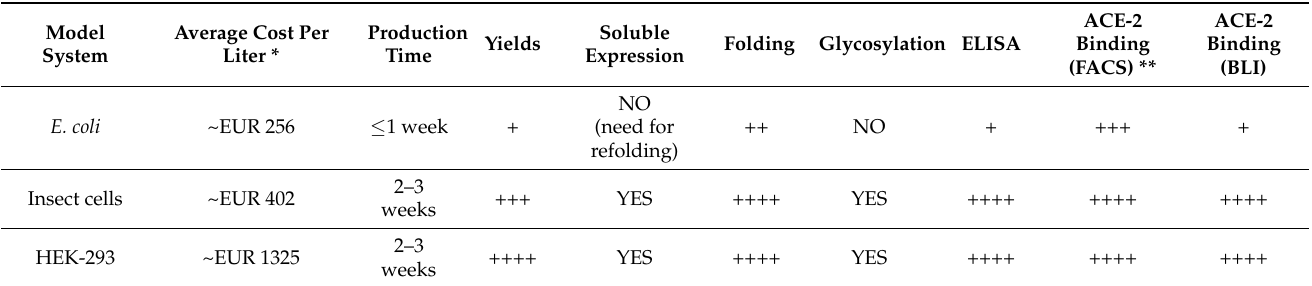
Table 1. Overview of the main aspects of the RBD produced in the three major model systems. * The cost per liter accounts for the resources (cell media, transfection reagents, disposables, etc.) used in the upstream and downstream processes. It does not include costs related to the cloning process, the manpower, nor the equipment usage. ** Flow cytometry assay using Vero E6-cells to measure RBD–ACE-2 binding. + (low) ++ (medium) +++ (high) ++++ (very-high).